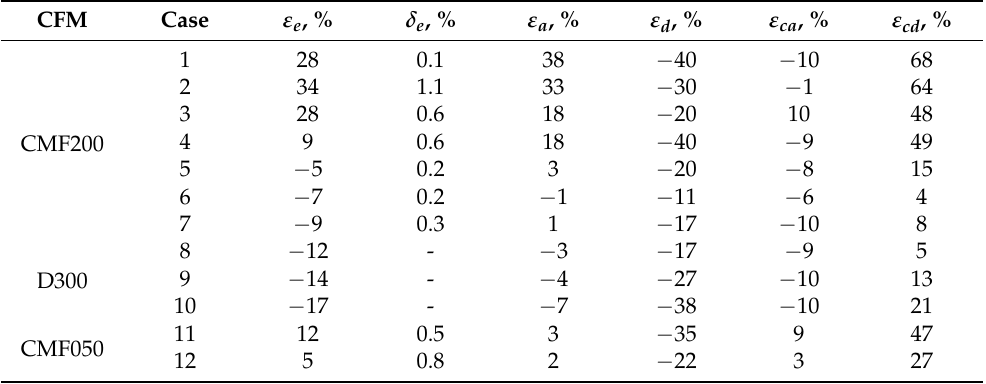
Table 4. The estimated ( ε a and ε d ), experimentally observed ( ε e ) and corrected ( ε ca and ε cd ) errors of